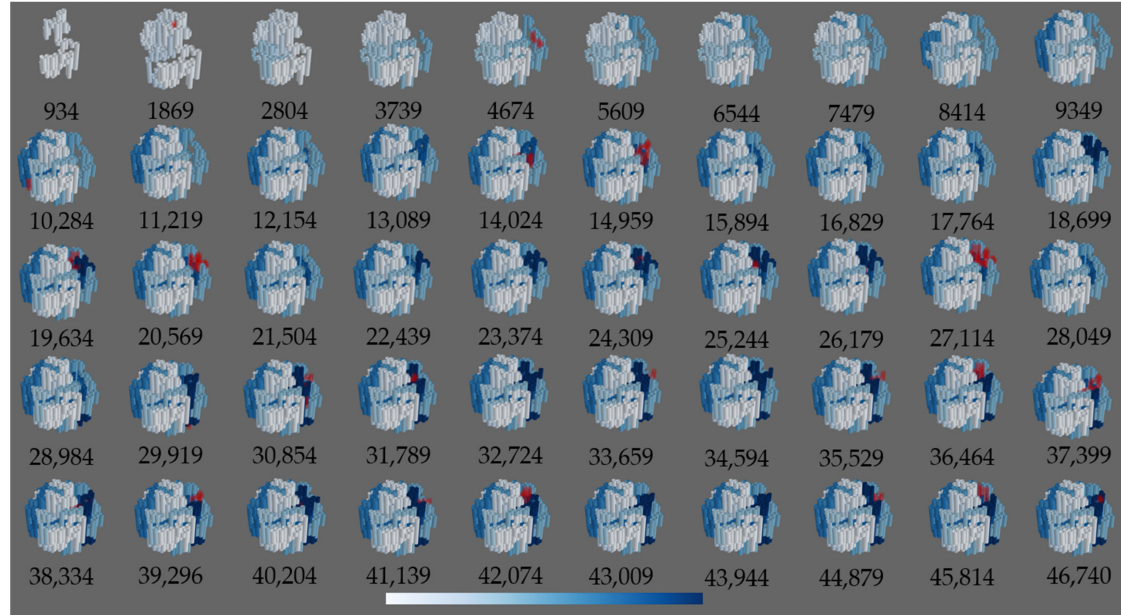
Figure 12. Scaffold growth visualization using blue color map for middle snub cube in Figure 6b with a total length of 8484 bp, where the scaffold is represented as cylinders. The total iteration of the shape annealing schedule is divided equally into 50 steps, where an image is generated at each step. The blue color map starts from a light blue tint, which represents the beginning of the scaffold, to dark blue tint, which represents the end of the scaffold. Below each image is the iteration number during the annealing schedule. The transparent red cylinders signify the application of the reversal rule.